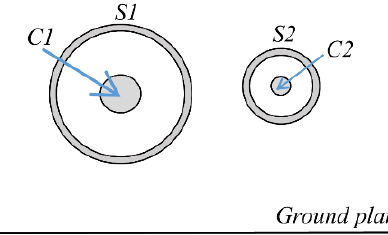
FIGURE 8. Example of two coaxial cables in parallel to a ground plane (geometrical